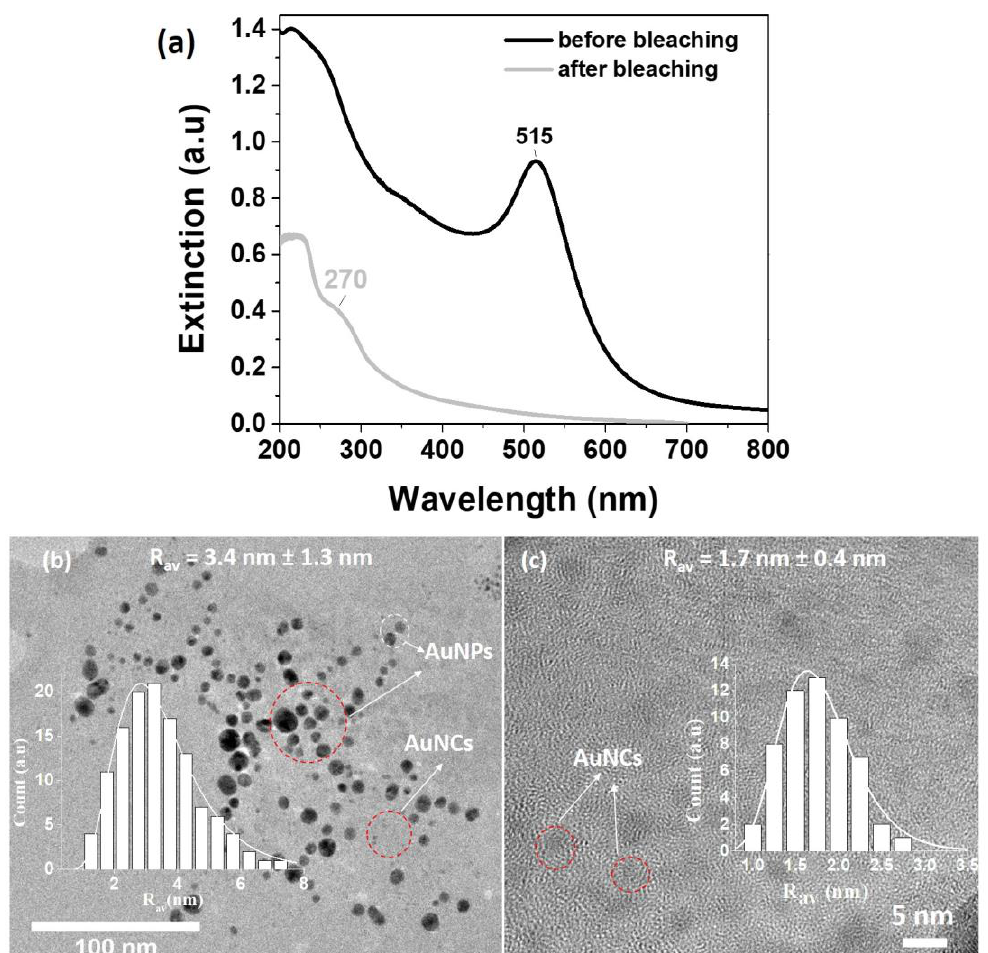
Figure 2. ( a ) Extinction spectra of gold nanomaterial before (black curve) and after (gray curve) the bleaching. ( b ) TEM image of the fresh synthesized nanomaterial, comprising both AuNPs and AuNCs. ( c ) TEM image of the AuNCs after the bleaching by evaporation and centrifugation. In both TEM images is the statistical distribution of the radius R of the colloids.